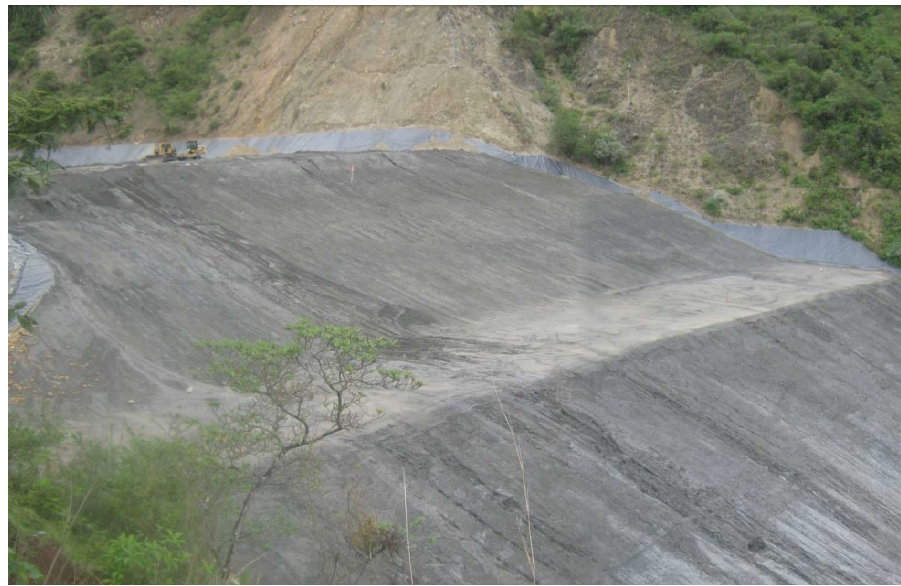
Figure 62. Curaubamba Filtered TSF–Terraces View [38,39]. Minerals 2022 , 12 , x